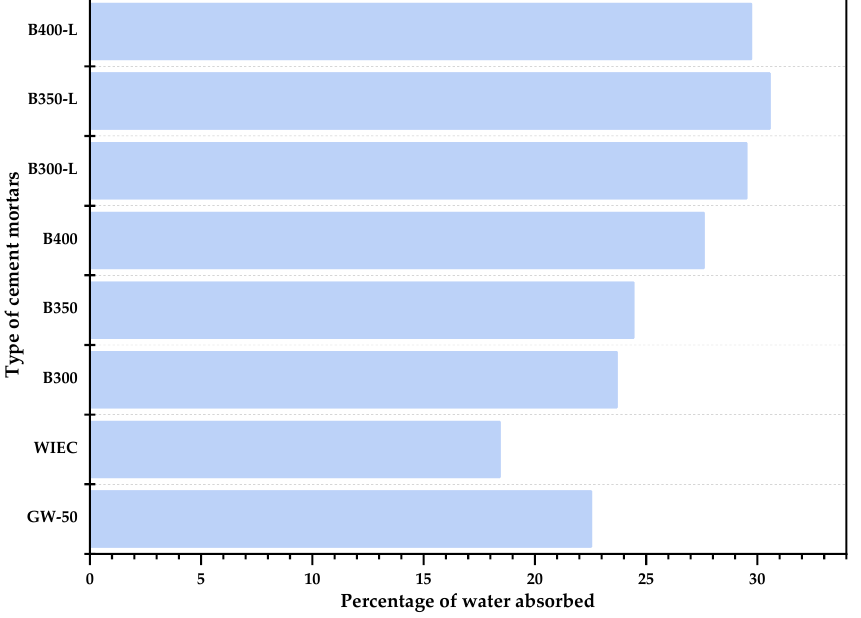
Figure 6. Water absorption by immersion for the different mixture specimens.